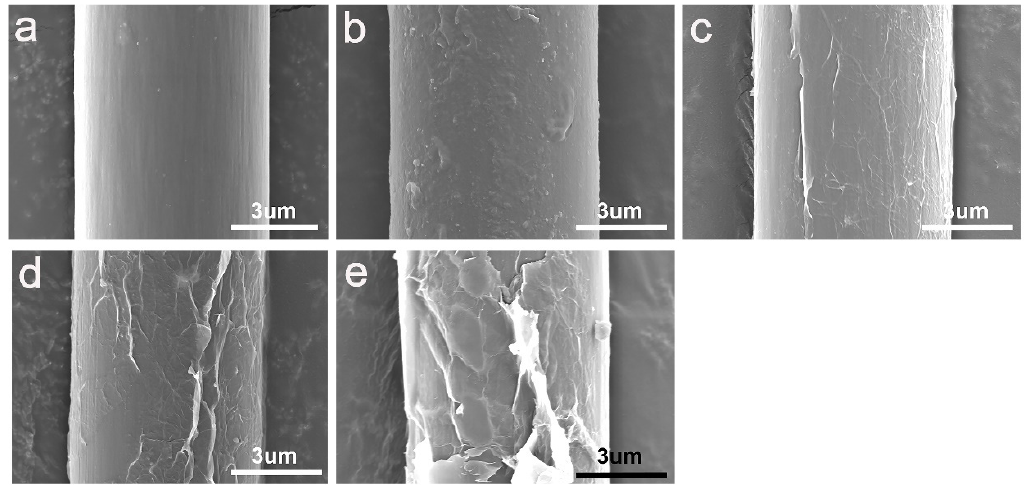
Figure 6. SEM images of carbon fibers ( a ) Untreated CF, ( b ) CF-KHN + , ( c ) CF-KHN + -2GO, ( d ) CF- KHN + -4GO, ( e ) CF-KHN + -6GO.